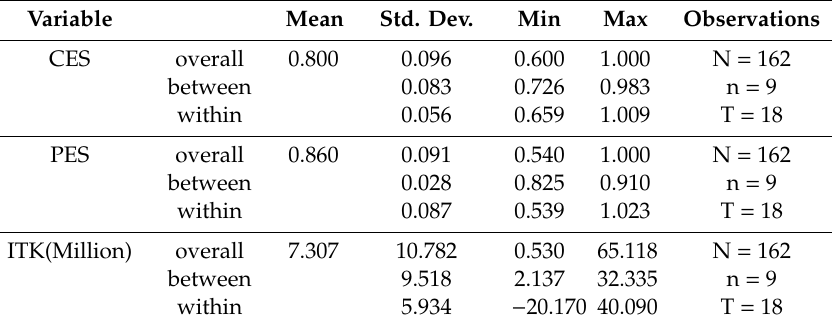
Table 3. Summary statistics of variables of